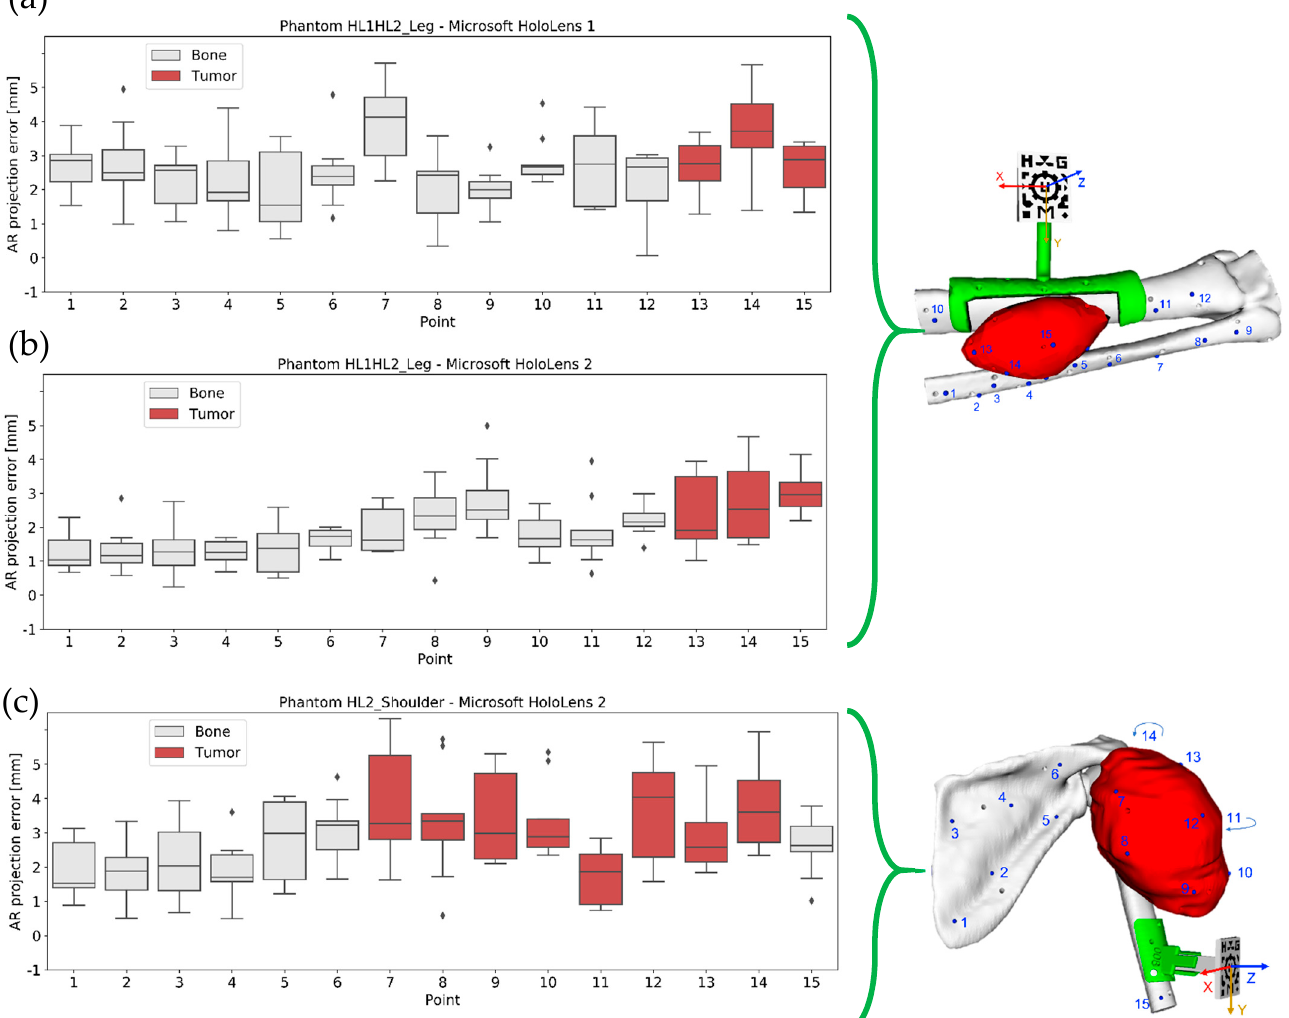
Figure 5. AR projection error by point obtained for patient ( a ) HL1HL2_Leg with Microsoft HoloLens 1, ( b ) HL1HL2_Leg with Microsoft HoloLens 2, and ( c ) HL2_Shoulder with Microsoft HoloLens 2. On the right, positions on the virtual control points over the phantoms. Black diamonds represent outliers.